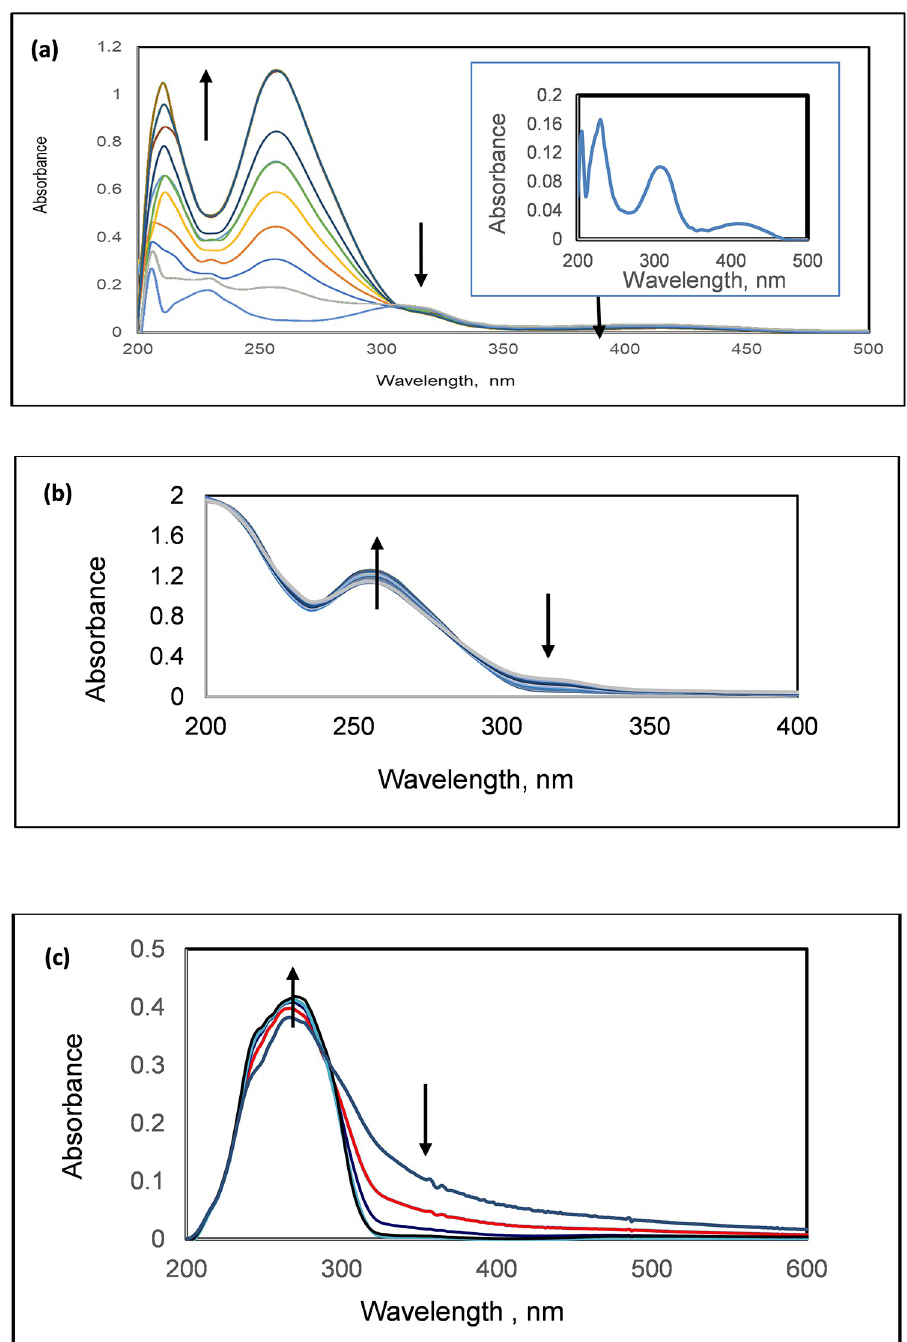
Fig 1. Spectrophotometric titrations of (a) A 5 × 10 − 5 M GW-2974 with 10.0 μ l increments of human telomeric G- quadruplex DNA (1.44 × 10 − 4 M). (b) A 4.00 × 10 − 6 M human telomeric G-quadruplex DNA with 10.0 μ l increments of GW-2974 (1 × 10 − 5 M). (c) A 5 × 10 − 5 M SCH-442416 with 5.0 μ l increments of human telomeric G-quadruplex DNA (1.44 × 10 − 4 M). All titrations were carried out in Tris–KCl buffer, pH 7.4.